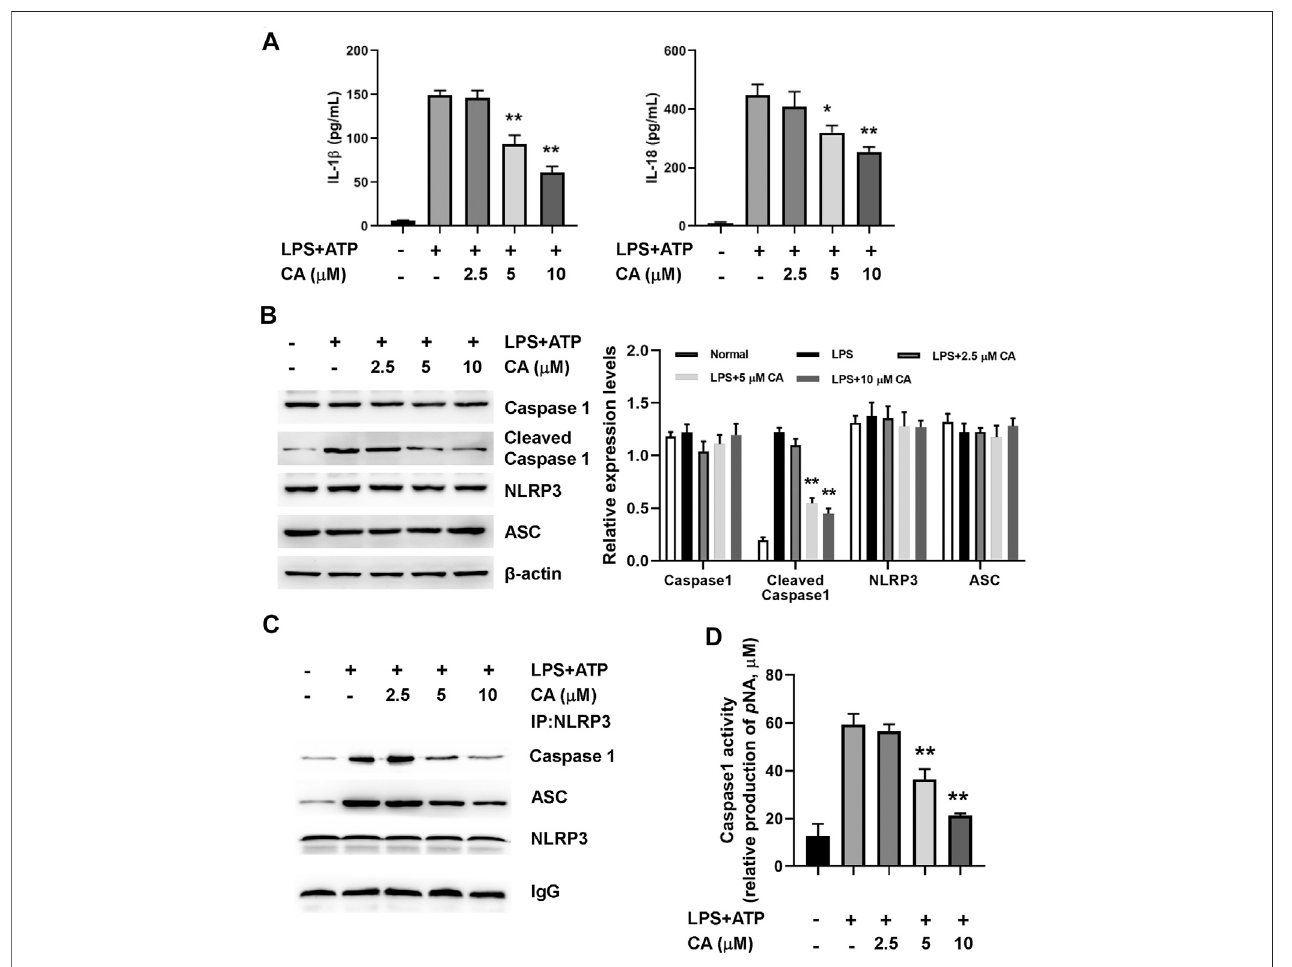
FIGURE6| CalycosininhibitsLPS-inducedNLRP3in fl ammasomeactivationinBMDMs.BMDMscellsweretreatedwiththedifferentconcentrationsofcalycosinin the presence of 500 ng/ml LPS and 5 mM ATP for 24 h. (A) The levels of IL-1 β and IL-18 in the supernatant were determined by ELISA assay. (B) The protein levels of NRLP3 in fl ammasome were determined by western blot. The quantitative densitometry of the protein expressions was determined by Image J software. Densitometric valueswere normalized to β -actin. (C) The effect ofCAon theinteraction among NLRP3, ASC, and caspase 1 weredeterminedby co-immunoprecipitation assay. (D) The caspase 1 activity in BMDMs was determined by a commercial kit. Data are presented as means ± SEM. * p < 0.05; ** p < 0.01 vs. the LPS+ATP group.